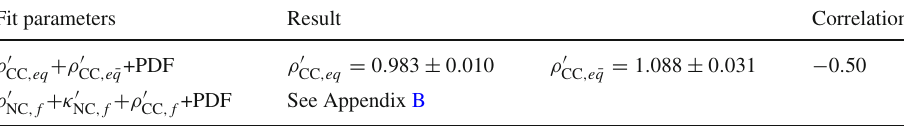
Table 5 Results for ρ (cid:6) Fit parameters Result CC parameters. The other parameters α , m W , m Z , m t , m H and m f are fixed to their SM values. The uncertainties quoted correspond to the total uncertainties